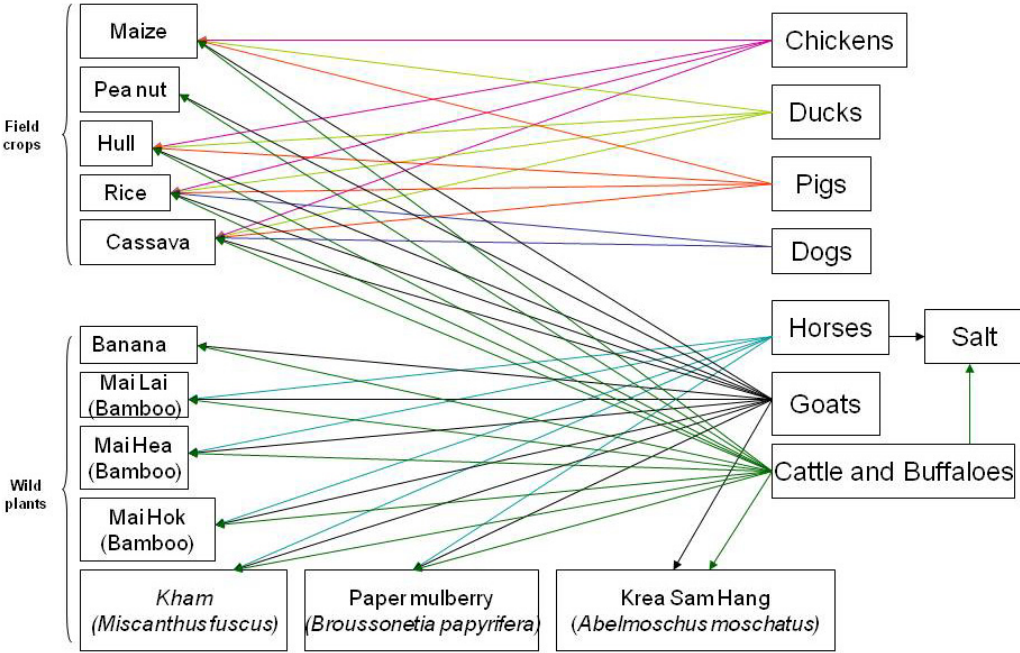
Figure 9. Local classification of the main forage species associated with domestic animals in the communities in northern Laos. Source: Data derived from focus group